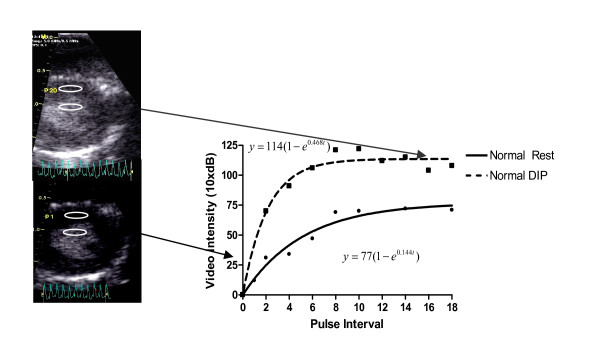
Example of quantitative perfusion analysis. The rBV was quantitatively estimated by the division of myocardial plateau video intensity and the adjacent left ventricular intensity in the near wall cavity at rest and during hyperaemia (DIP).